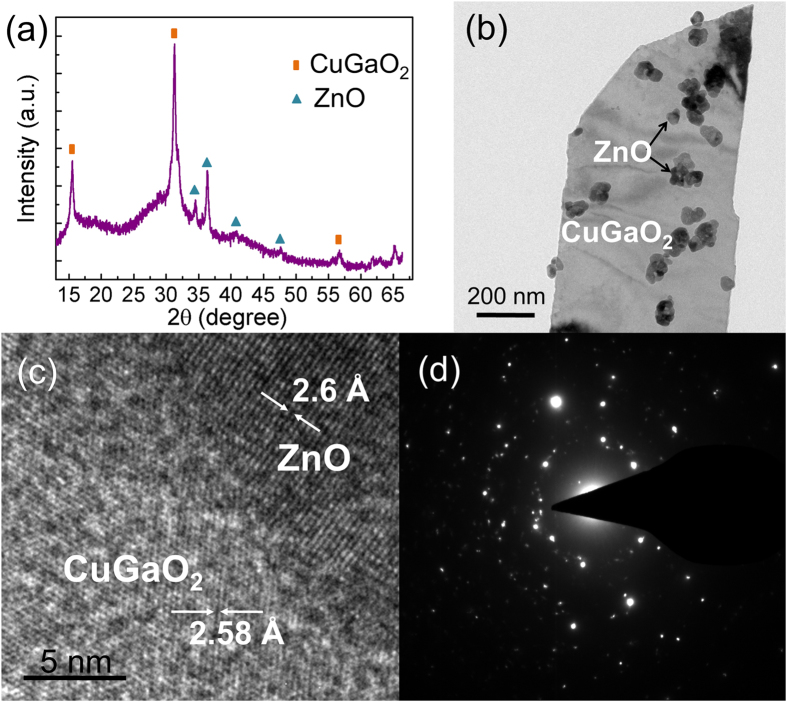
(a) XRD pattern of CuGaO2/ZnO nanocomposites, (b) TEM image of part of CuGaO2/ZnO nanocomposites. The corresponding (c) HRTEM image and (d) SAED pattern of CuGaO2/ZnO nanocomposites.